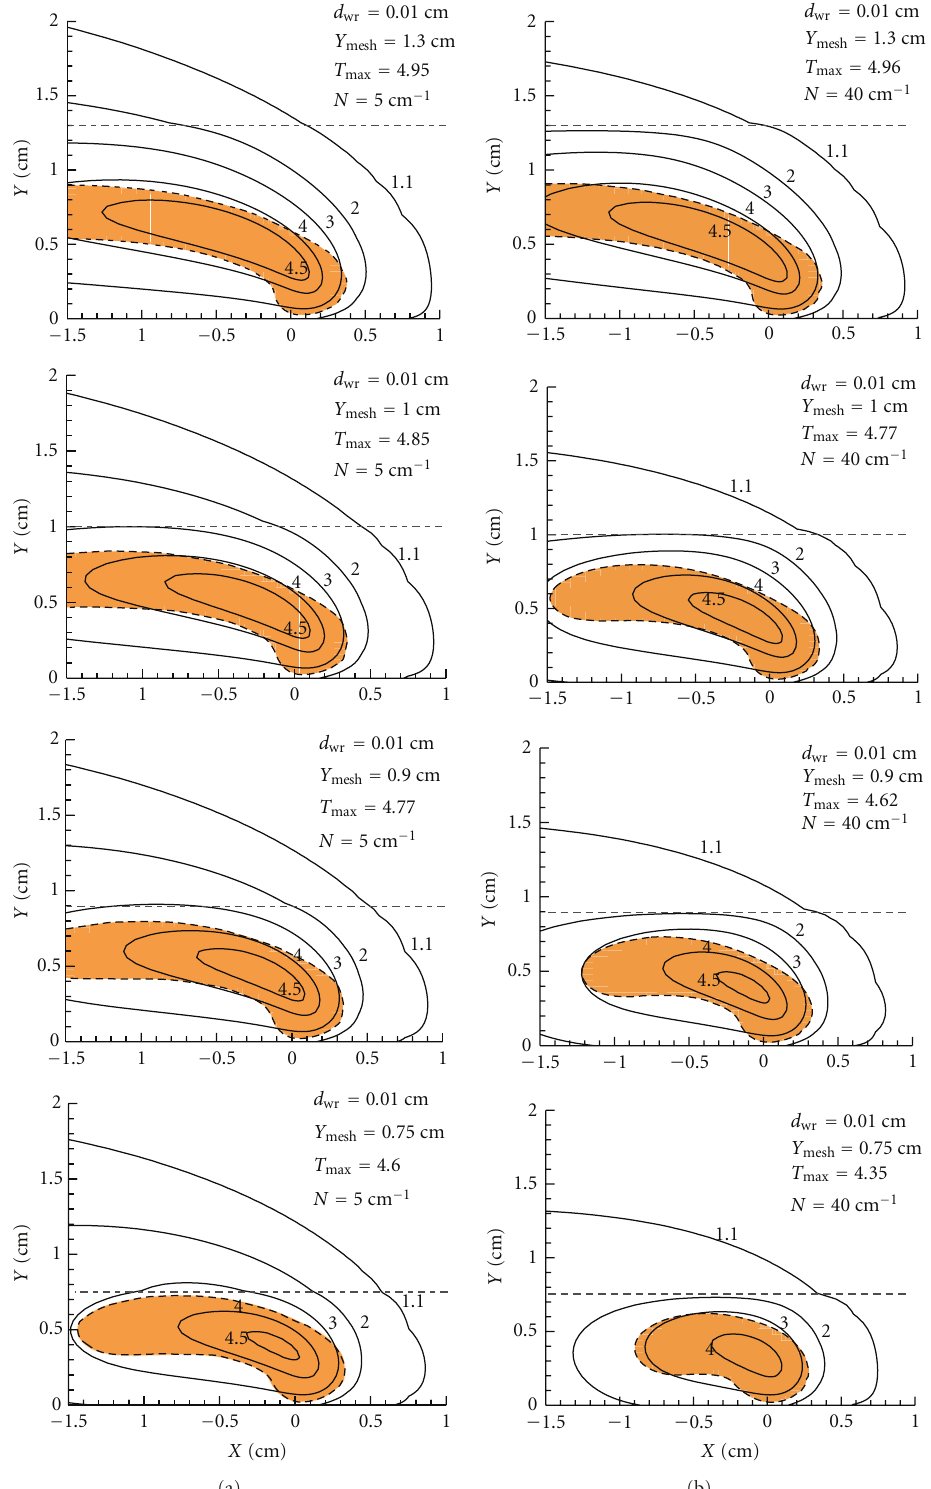
Figure 3: E ff ect of N and Y mesh on flame size and temperature field—(a) N = 5cm − 1 and; (b) N = 40cm − 1 . The dashed line represents wire